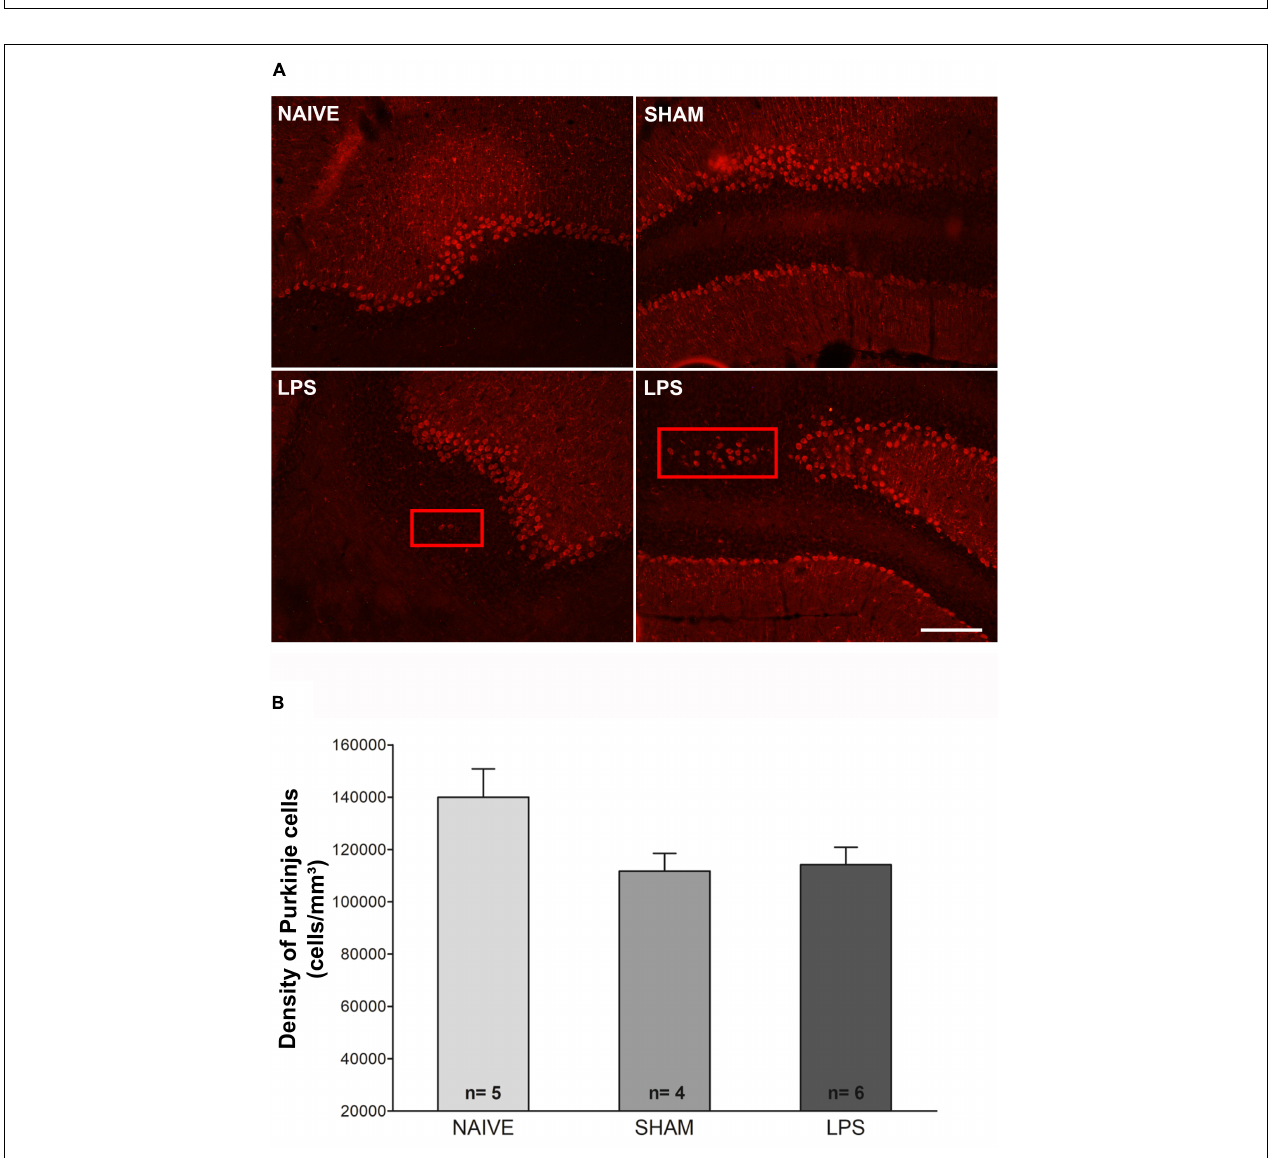
FIGURE 4 | Photomicrographs and Purkinje cell densities in the cerebellum of adult rats (PN89) after early neonatal LPS induced inflammation. (A) Representative immunofluorescence of calbindin + cells in the three animal groups. Note the presence of Purkinje cells positioned outside the Purkinje cell layer (red rectangles) in LPS animals. This was not observed in control groups. Calibration bar: 200 µ m. (B) There was no significant difference in Purkinje cell density among groups. Values: mean ± SEM. ANOVA, p > 0.05.